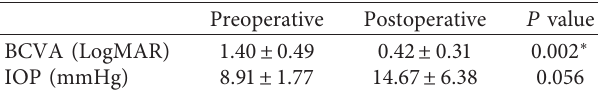
Figure 1: Preoperative and postoperative ultrasound biomicroscopy (UBM) images of Patient 1. (a, c, e, g) Preoperative UBM findings show the cyclodialysis clefts at the 2 o’clock position; the other ciliary body was detached. (b, d, f, h) Postoperative UBM findings show that the cyclodialysis cleft is closed two weeks after surgery. Table 2: Comparison of preoperative and postoperative values.